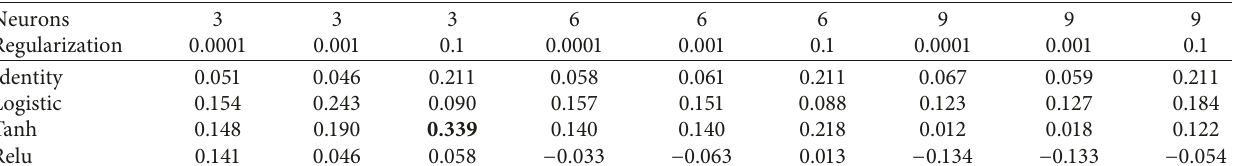
Figure 3: The true and predicted average grades with lasso. Table 3: Correlation between predicted and real grades for different MLP models.